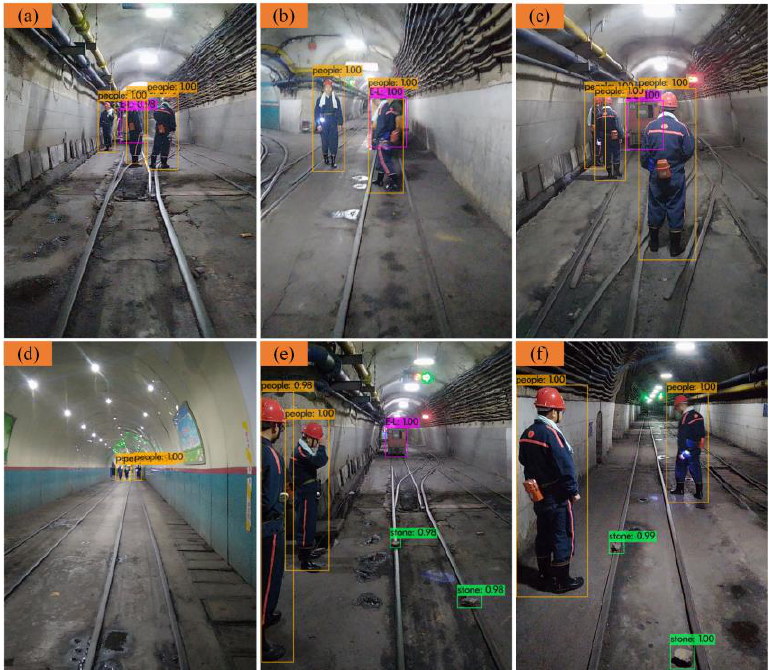
Figure 10. Detection results for two scenes with occlusions and small targets. ( a – c ) Occlusion targets; ( d – f ) small targets.